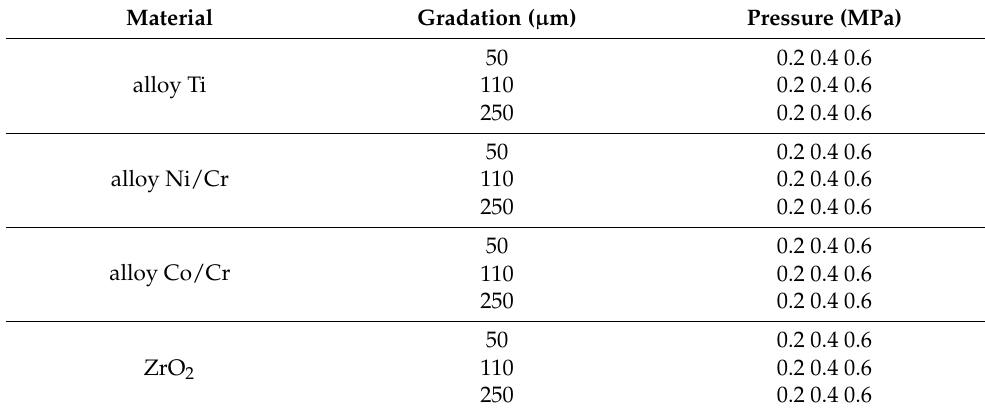
Table 1. Materials and airborne-particle abrasion